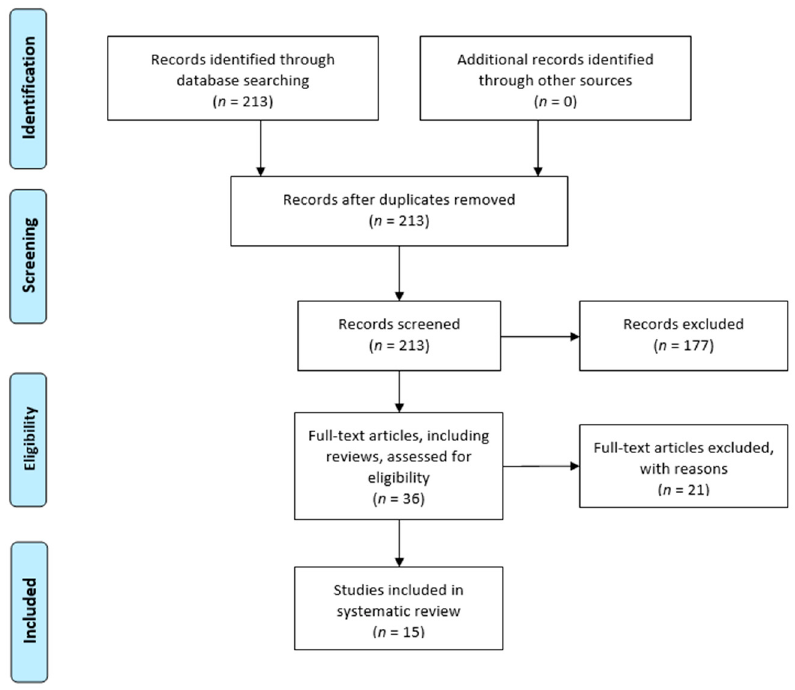
Figure 1. Prisma 2009 flow diagram of the included studies.